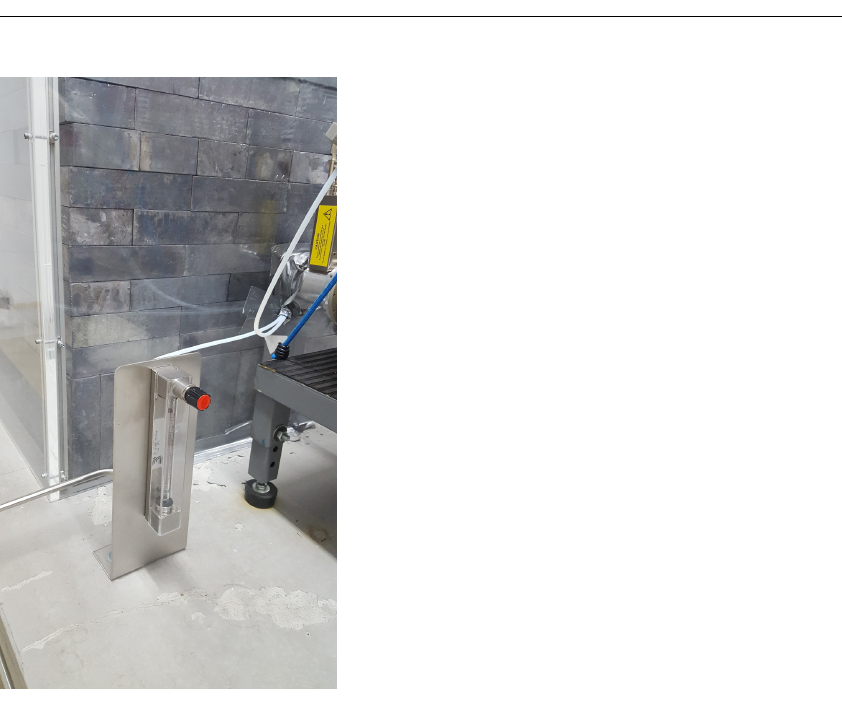
Figure 23. ATEKO-Air Rotameter with valve to measure and regulate air flow rate.